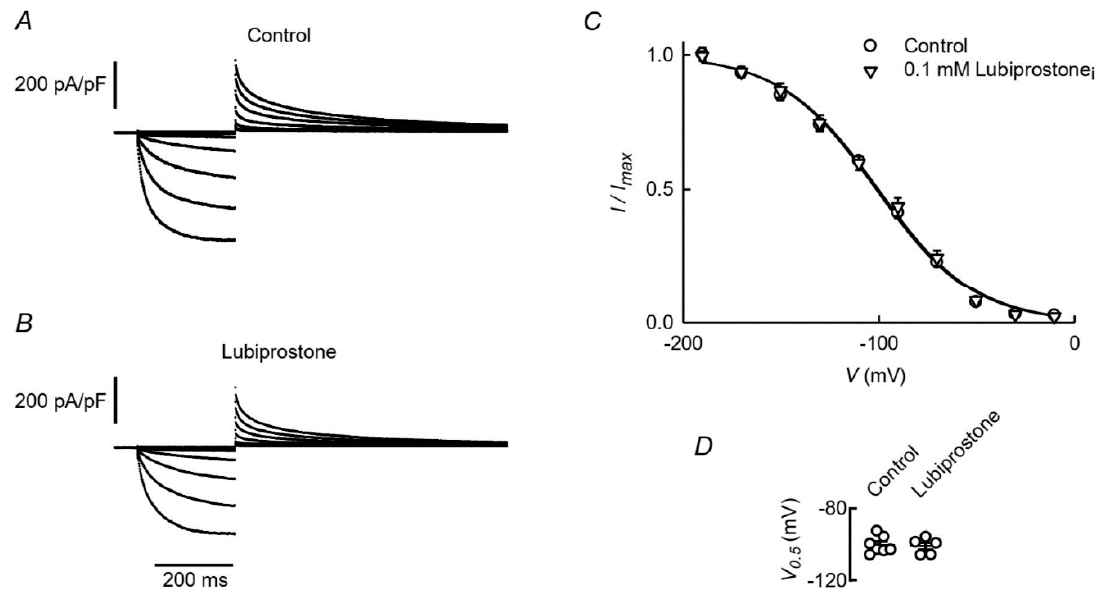
Figure 4. E ff ect of intracellular lubiprostone on ClC-2 mediated currents. Whole cell currents measured in HEK-293 cells transfected with ClC-2. ( A , B ): representative current traces, elicited from a V h of − 30 mV by test pulses ranging from − 190 to − 10mV in 20mV steps. These were followed by a pulse to 30mV. ( A ): control experiment with an extra- and intracellular solution containing respectively 146 and 35 mM Cl − . ( B ): a similar experiment except for the addition of 0.1 µ M lubiprostone to the intracellular solution. ( C ): Tail currents plotted against the voltage of the main activating pulse are means ± SEM of 7 and 5 experiments, respectively. The lines are the averaged Boltzmann fits of the individual experiments whose V 0.5 values are shown in D .